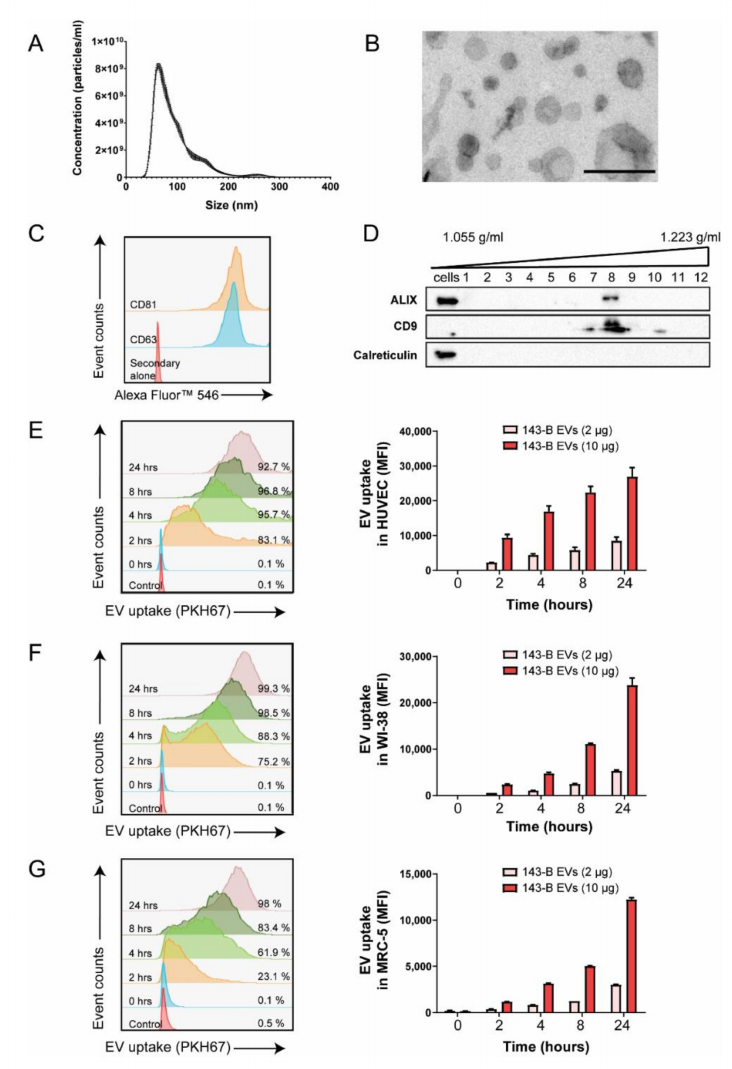
Figure 1. Characterization of osteosarcoma 143-B-derived extracellular vesicles (EVs) and their uptake by recipient cells. ( A ) 143-B EV size distribution assessed by NanoSight analysis. ( B ) Transmission electron micrographs of 143-B EVs. Scale bar, 250 nm. ( C ) Representative histogram of flow cytometry analysis of exosomal markers CD63 and CD81 in 143-B EV-coated beads. ( D ) Western blot analysis of EV markers (ALIX, CD9) and a cellular marker (calreticulin) in 143-B whole cell protein extracts and in eluted EV fractions from iodixanol based density gradient ultracentrifugation of 143-B EVs. Internalization of PKH67-labelled 143-B EVs by human umbilical vein endothelial cells (HUVEC) ( E ), WI-38 ( F ) and MRC-5 ( G ) cells, as measured by flow cytometry. Representative histograms indicating the percentage of cells internalizing EVs (10 µ g) over time (left panels) and the quantification of mean fluorescence intensity (MFI) indicating dose- and time-dependent EV uptake (right panels). The data represent means ± SEM from three independent